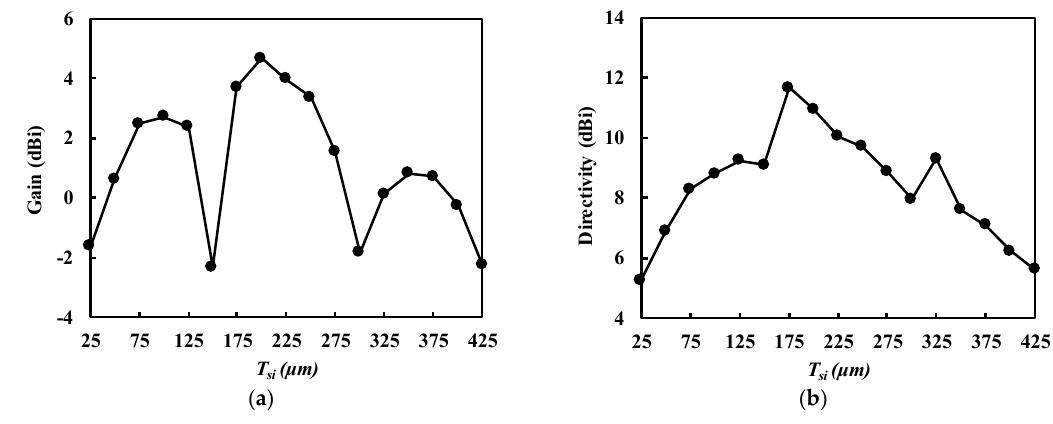
Figure 8. Simulated gain with respect to the thickness of Si substrate ( T Si ). ( a ) Gain. ( b ) Directivity.